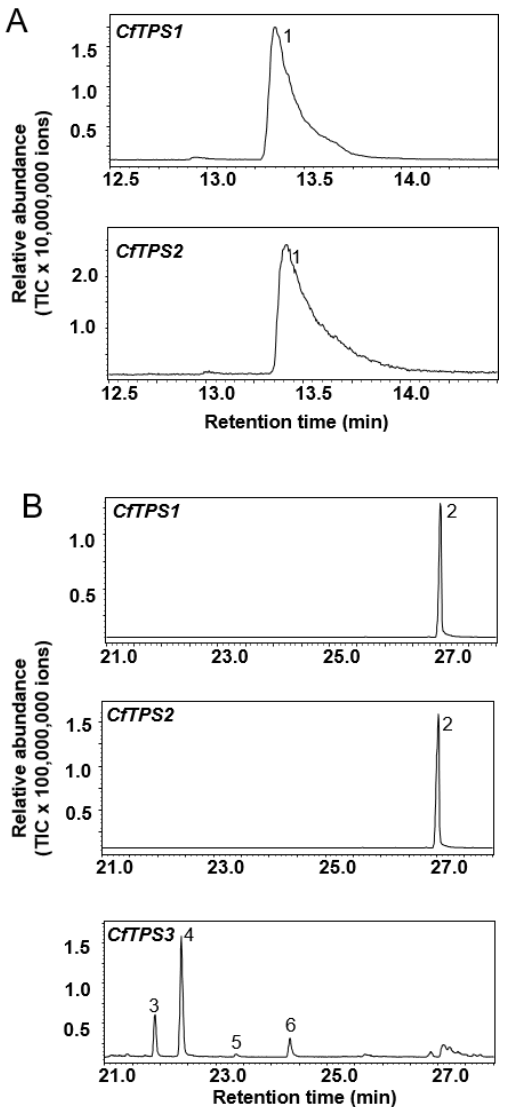
Figure 6. Functional characterization of recombinant CfTPSs . ( A ) Enzyme activity of CfTPS1-2 with geranyl diphosphate as substrate. Linalool (1) was identified as the product of CfTPS1 and CfTPS2 . ( B ) Enzyme activity of CfTPS1-3 with ( E,E )-farnesyl diphosphate as substrate. Nerolidol (2) was the